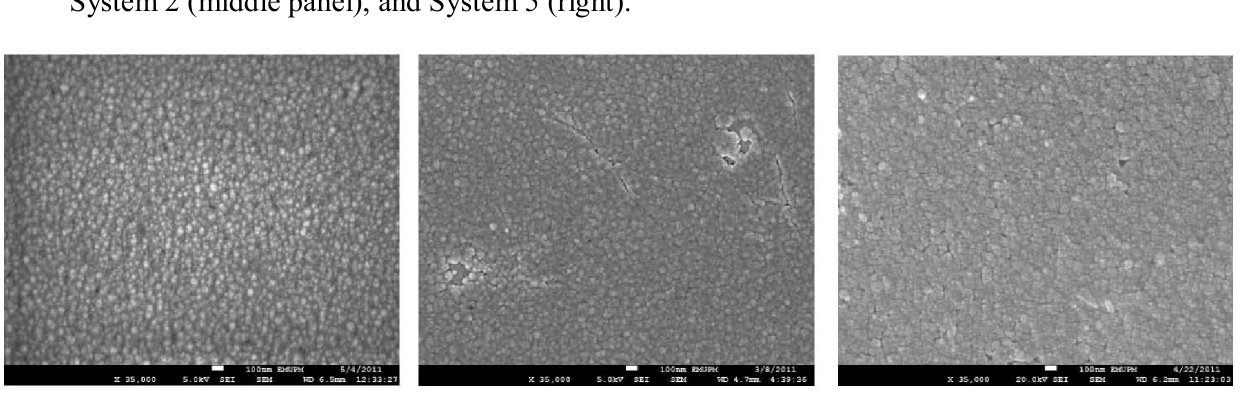
Figure 7. The EDAX spectra of CdS films for System 1 (undoped; left panel), System 2 (middle panel), and System 5(right